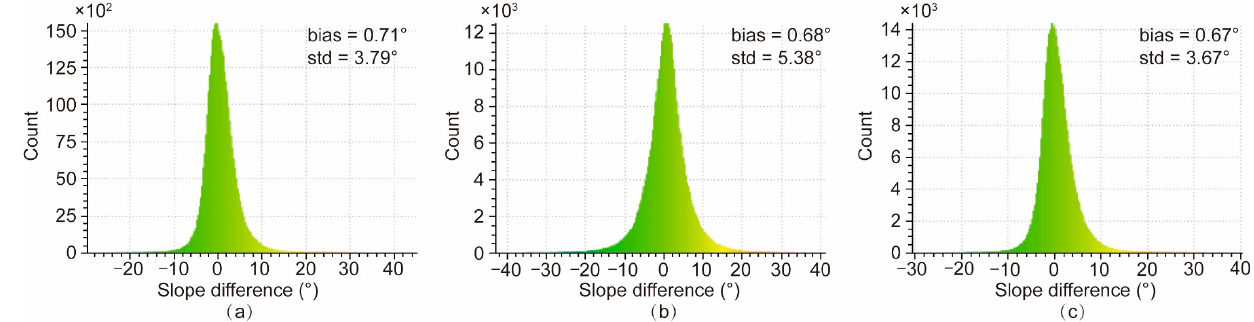
Figure 10. The histogram of the difference in the slope between the airborne LiDAR DEM and ( a ) GF-7 DEM Method1 , ( b ) GF-7 DEM Method2 , and ( c ) GF-7 DEM Method3 .